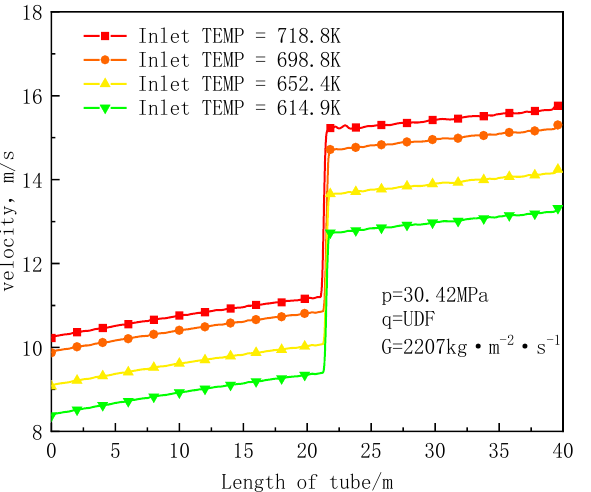
Figure 15. Velocity distribution of the tube length at different inlet temperatures ( p = 30.42 MPa, G = 2207 kg/(m 2 · s), T = 614.9~718.8 K).